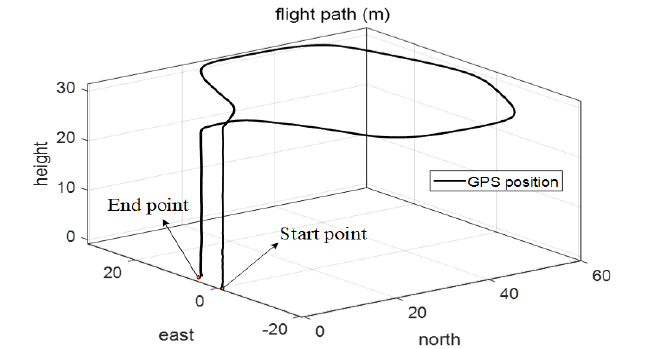
Figure 21. Autonomous flight